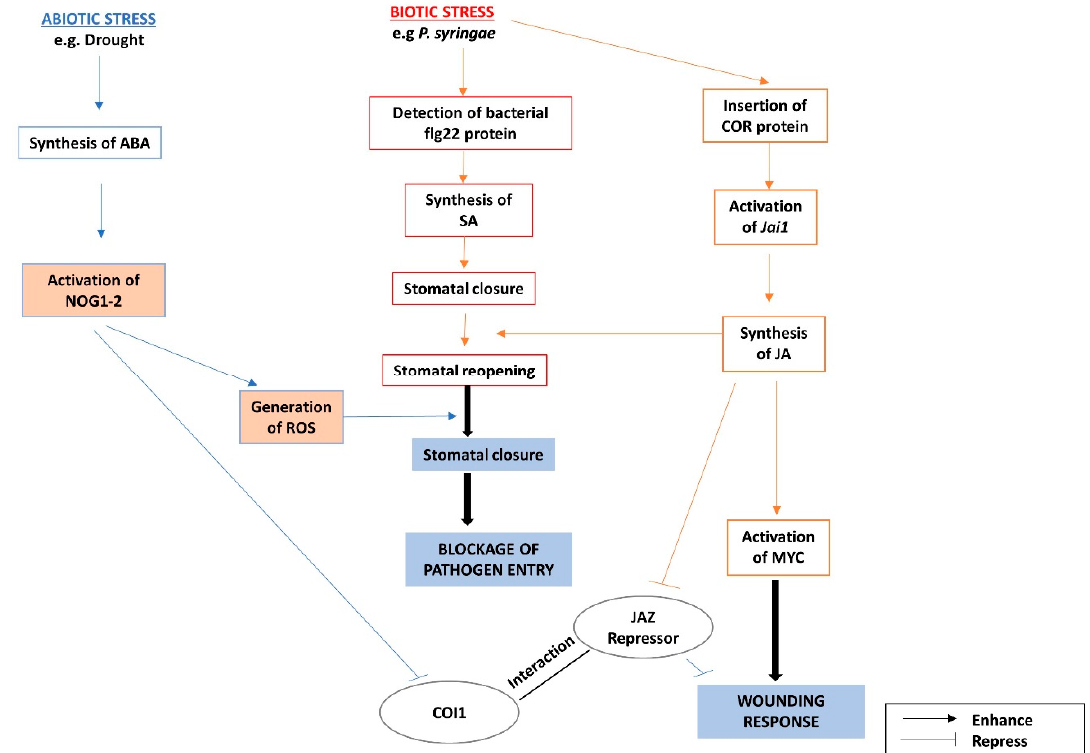
Figure 1. The interactions between the abscisic acid (ABA) and jasmonic acid (JA) signaling pathways under biotic and abiotic stresses are mediated through NOG1-2.